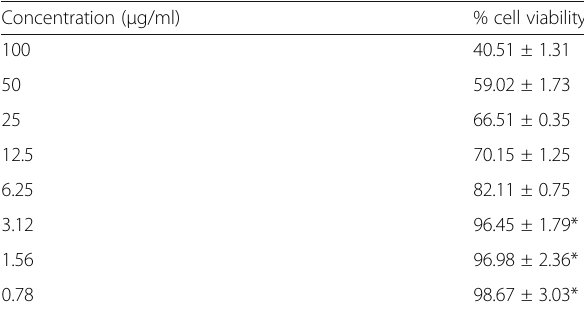
Table 1 Percentage cell viability of gallic acid isolated from the fruit of Terminalia chebula by the MTT assay on HeLa cells Concentration ( μ g/ml)